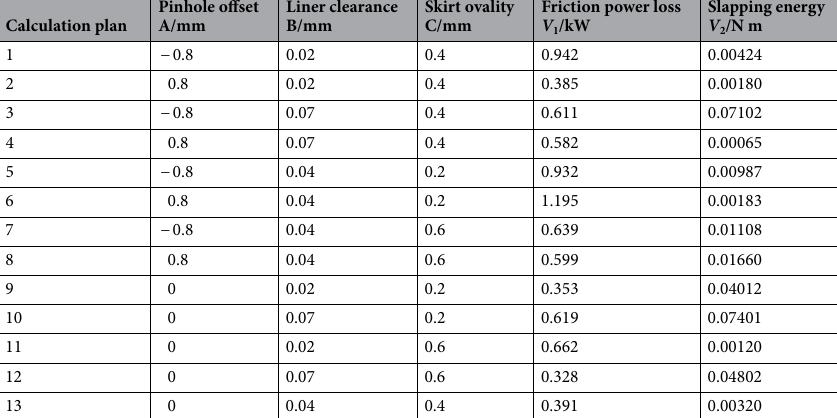
Table 4. Response surface factor values and simulation results.